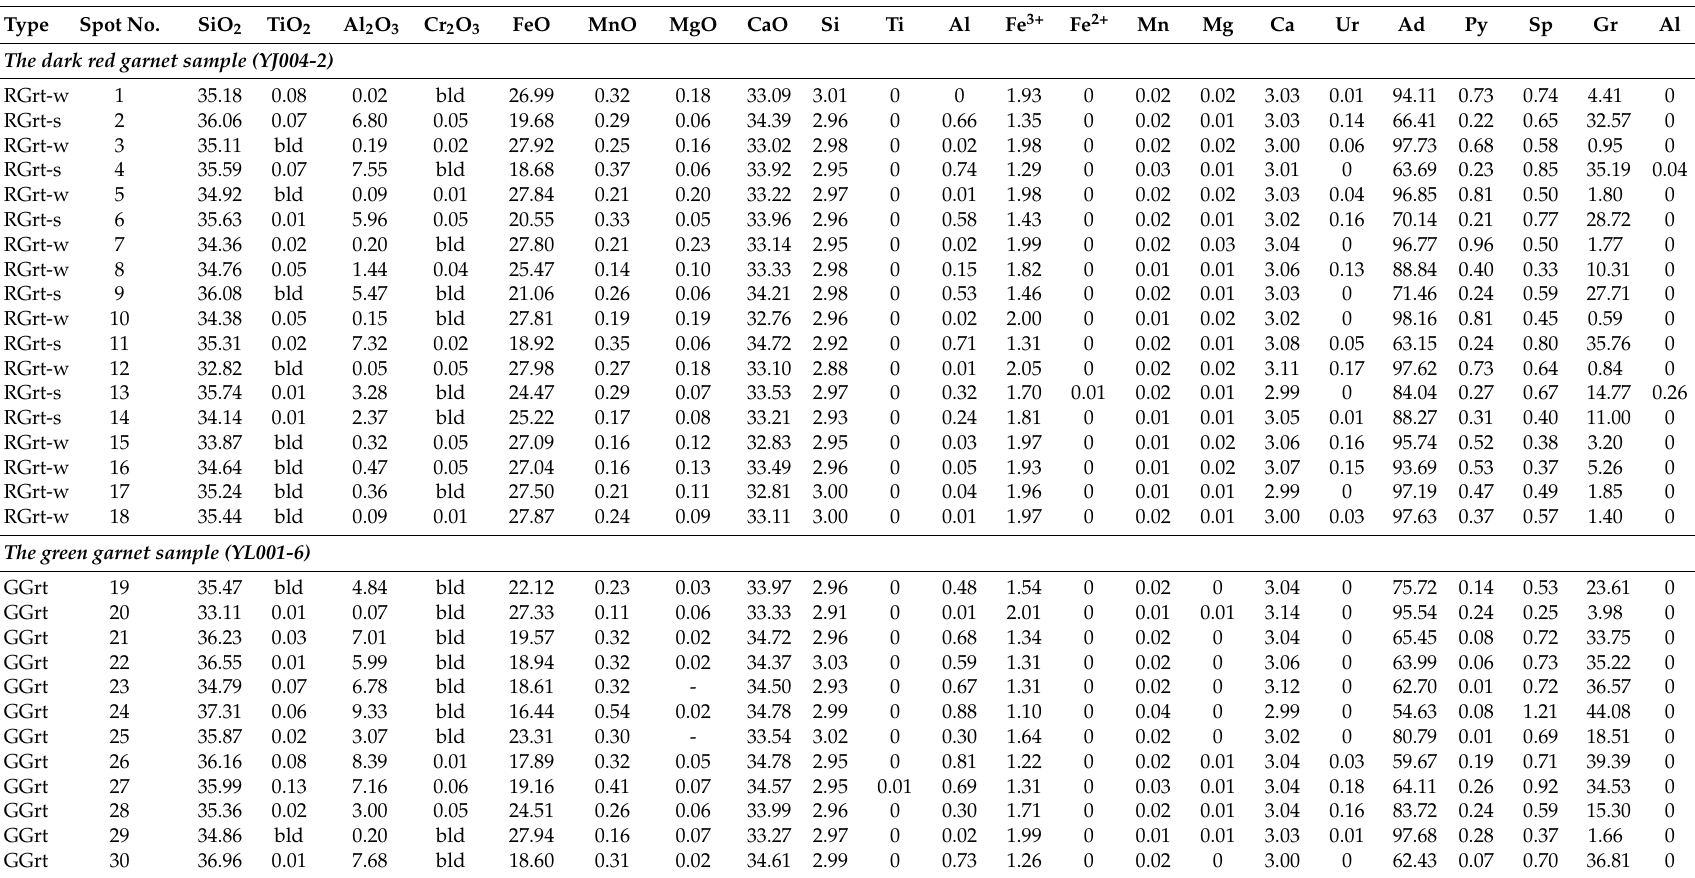
Table 1. Representative EMPA geochemical data (wt %) of the Yongping